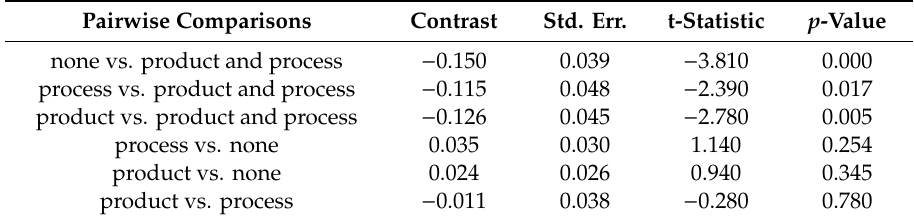
Table 5. Pairwise coe ffi cients’ contrast of innovation treatment coe ffi cients.